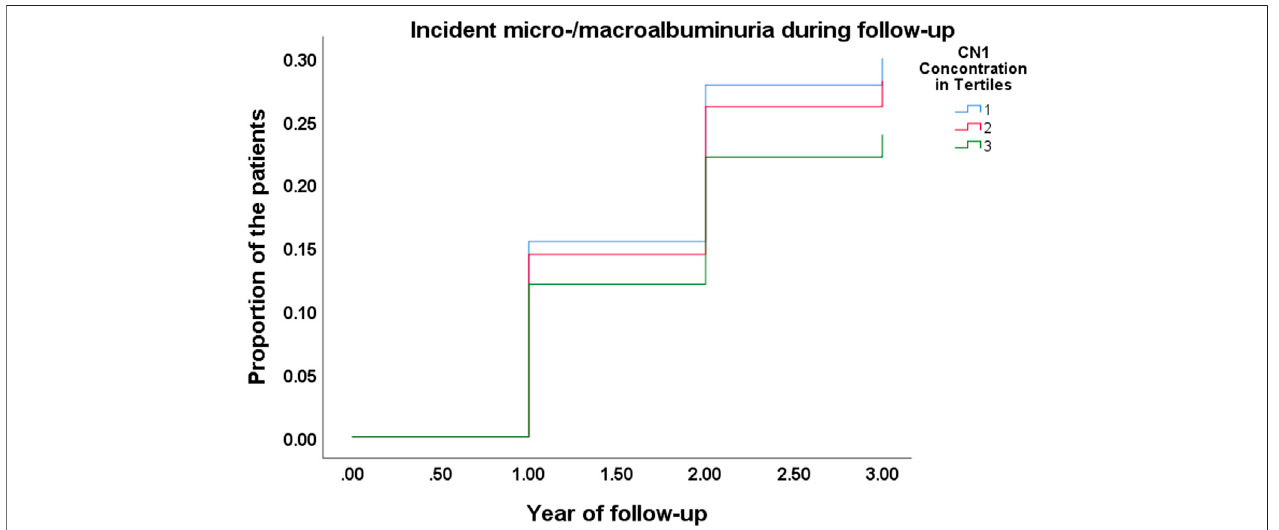
FIGURE 2 | Kaplan-Meier curve for incident of micro-/macroalbuminuria during the follow-up in different CN1 tertiles.